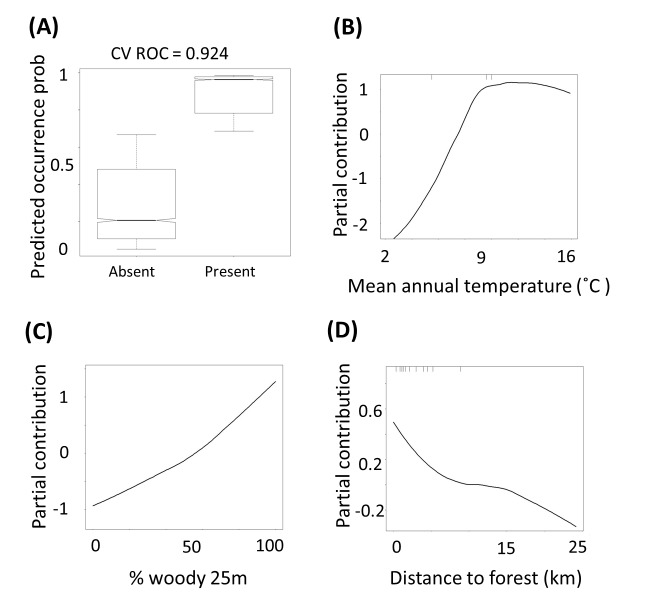
Partial contributions to Observed vs. Fitted tree occurrences within the simplified BRT model.The graphs show Observed vs. Fitted tree occurrences (A) and smoothed partial contributions within the simplified BRT model for (B) mean annual temperature (C) percentage woody cover in a 25 m radius and (D) distance to nearest forest. The smoothed partial contribution plots reflect the influence of a predictor variable when all other variables are held constant. CVROC is the cross-validated receiver operator curve (ROC) for the final boosted regression tree model. ROC is a measure of discrimination accuracy when predicting a binary response.